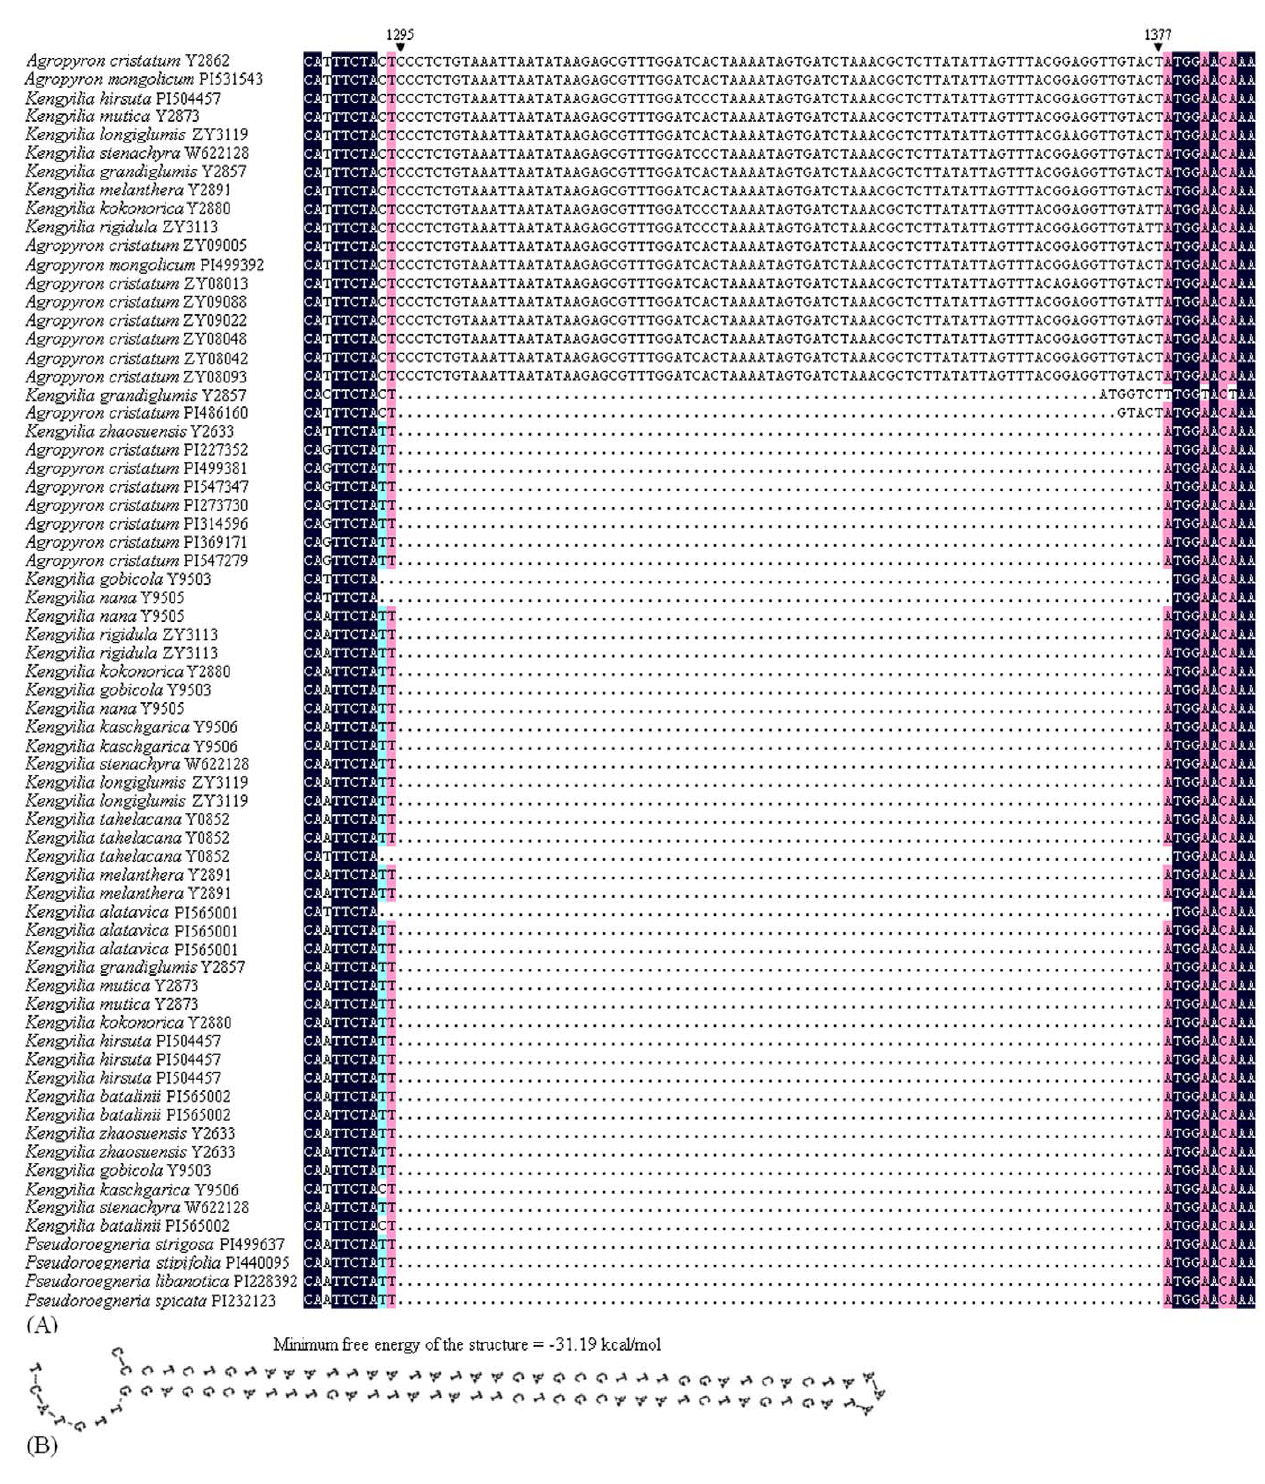
Figure 1. Pgk1 gene sequence analysis. ( A ) Partial alignment of the amplified sequences of the Pgk1 gene from Kengylia and its putative diploid species. ( B ) Secondary structure of MITE elements. doi:10.1371/journal.pone.0031122.g001 number of polymorphic sites at homoeologous loci of Pgk1 sequence from Kengyilia St, Y and P genomes was 51, 85, and 82, respectively. The overall number of polymorphic sites in the P genome of Kengyilia was lower than that in the P genome of diploid